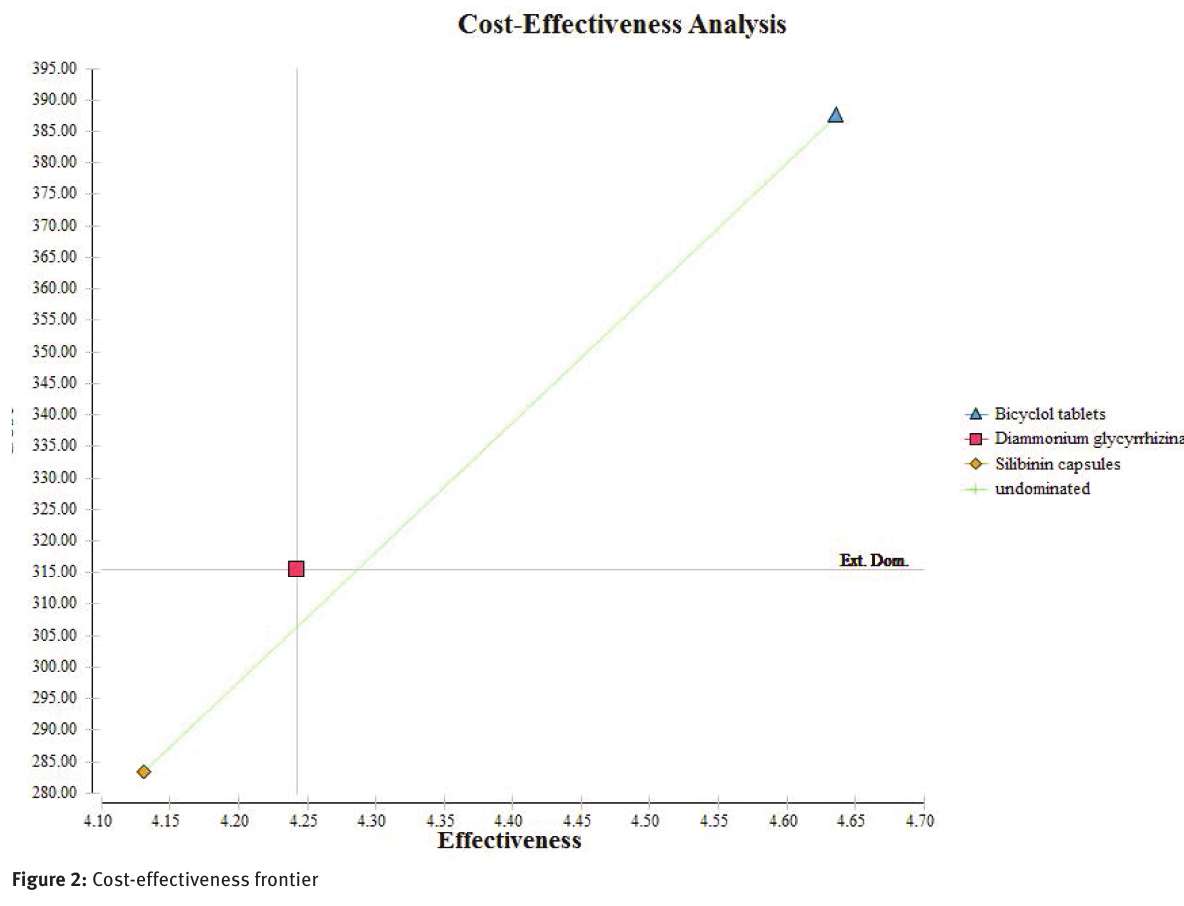
Figure 2: Cost-effectiveness frontier Table 4: Cost-effectiveness analysis of three groups based on effect degrees